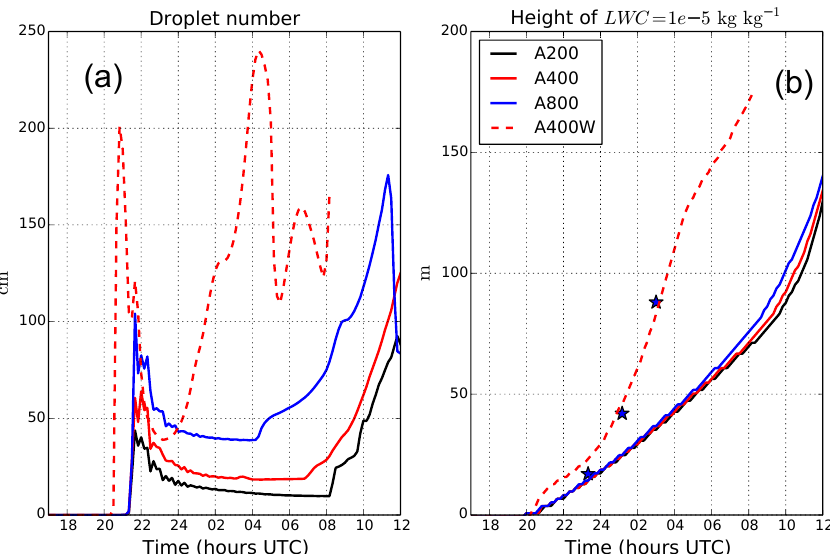
Figure 10. (a) Fog droplet number concentrations sampled at approximately 10m height and (b) the height of the fog-top layer interpreted as the 1 × 10 − 5 kgkg − 1 isoline for liquid water content. Observed values of the fog-layer depth based on tethered balloon data given by Porson et al. (2011) are shown with blue star symbols in panel (b) .